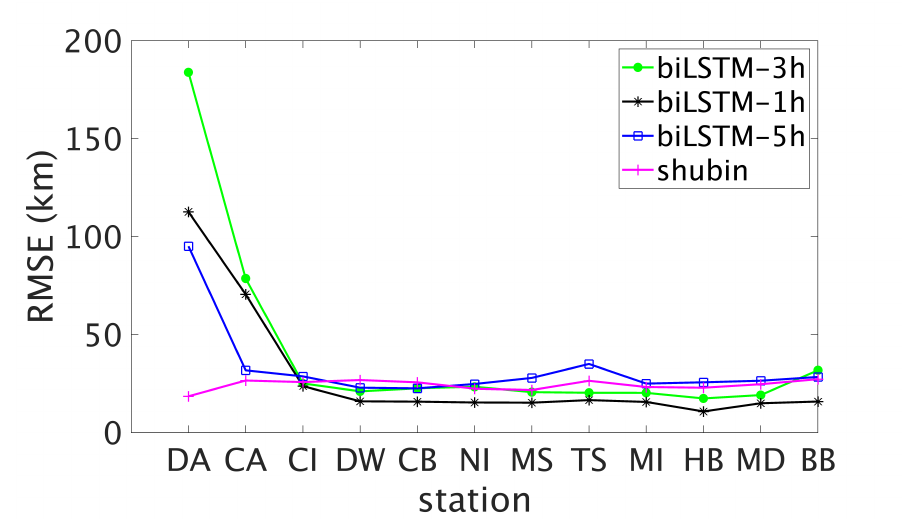
Figure 8. Model performances in forecasting 1, 3, and 5 h later at each station.